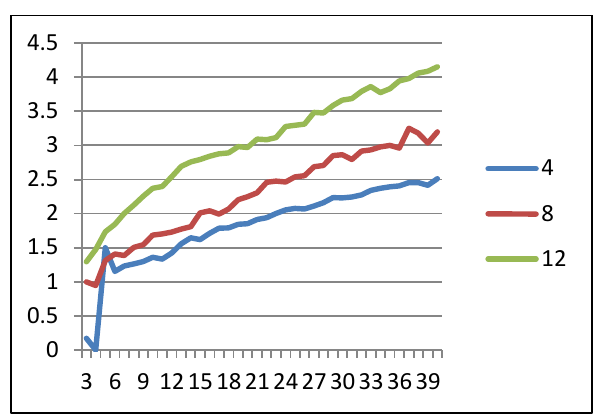
Fig. 9. Speed up rate for s equal to 4, 8 and 12 vertical axis: speed up rate value horizontal axis: the matrix